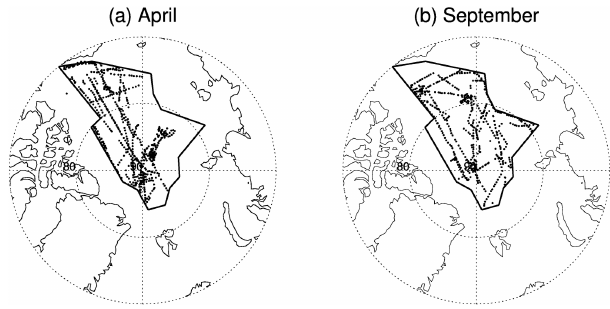
Figure 1. US submarine sea ice draft observations in April (a) and September (b) over the Arctic Ocean from 1984 to 2000. The irreg- ular polygon outlines the SCICEX data release